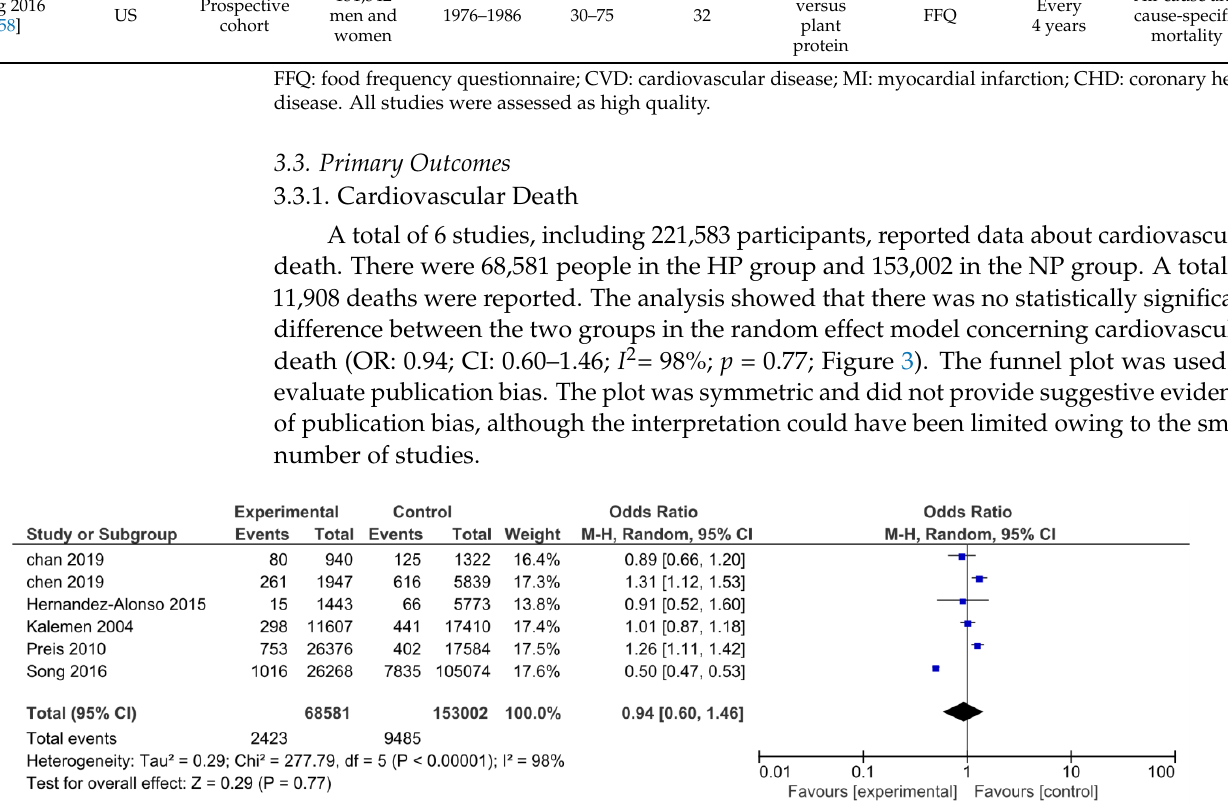
Figure 4. Forest plot for the association between HP intake and risk of non-fatal stroke. [15,51,56]. 3.4. Secondary Outcome A total of 13 studies, which included 525,047 participants, provided data on the com- posite outcomes. There were 177,826 patients in the HP group and 347,221 in the NP group. Overall, 21,906 total cardiovascular events were reported, yet there was no